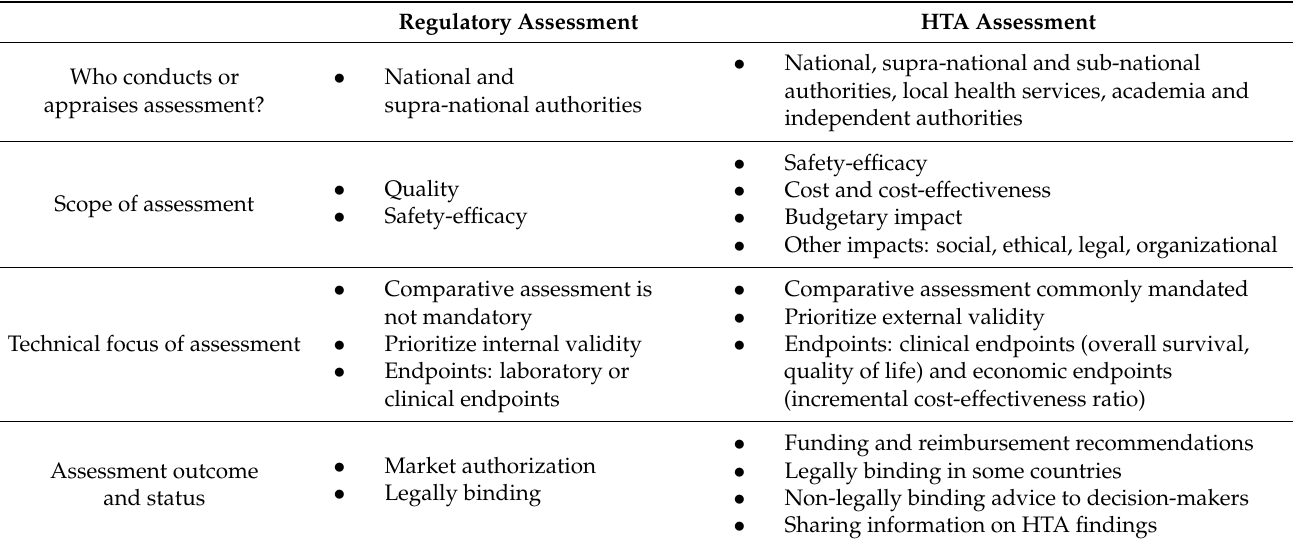
Table 1. Key elements of the Health Technology (HTA) and of regulatory